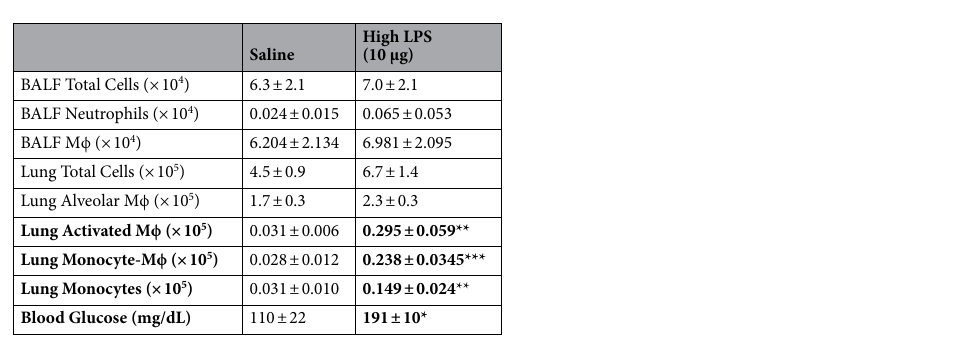
Table 1. Endpoints at 2 weeks following a one-time exposure to environmental inflammatory inhalant agent. There was no difference across treatment groups in lung neutrophils and lung lymphocyte populations. Statistical differences bolded and denoted as *p < 0.05, **p < 0.01, and ***p < 0.001. N = 3/group.